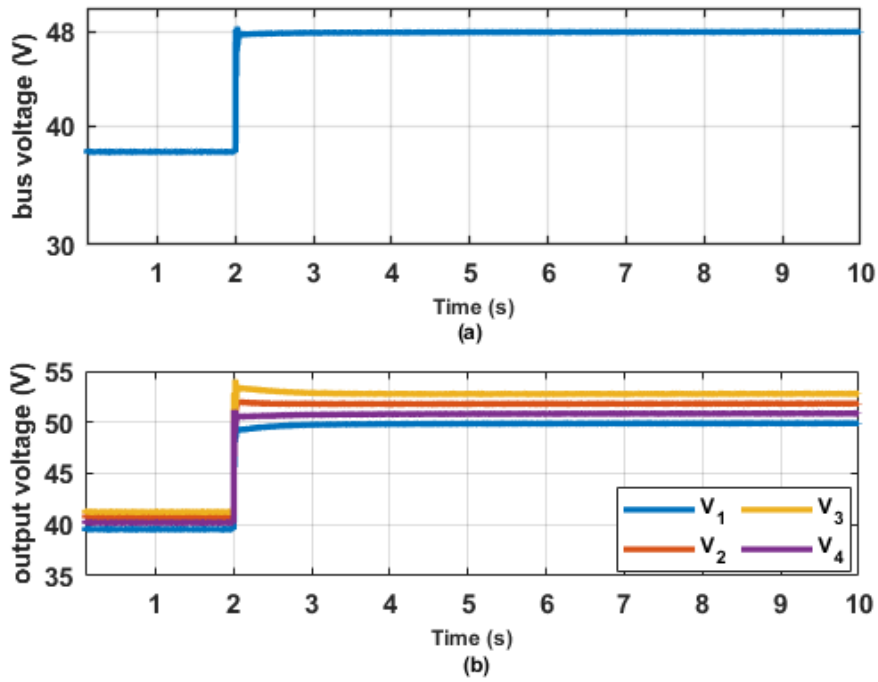
Figure 7. ( a ) DC bus voltage; ( b ) output voltage of DGs using Topology B.